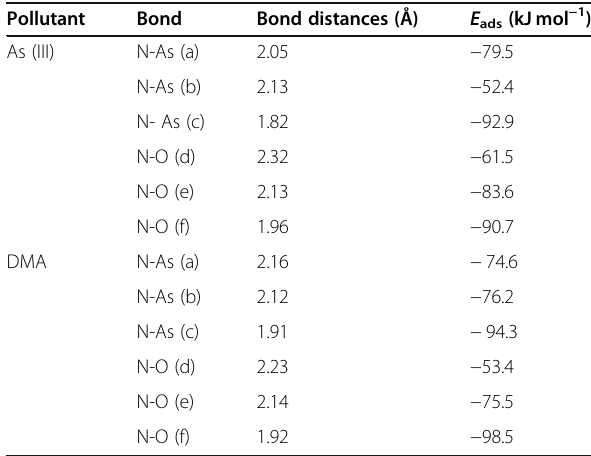
Table 3 Adsorption energies of As (III) and DMA adsorbed onto DETA-SBC